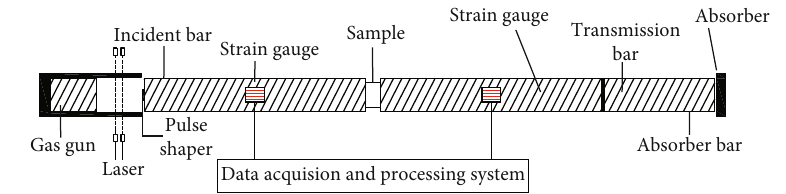
Figure 3: The SHPB testing system.